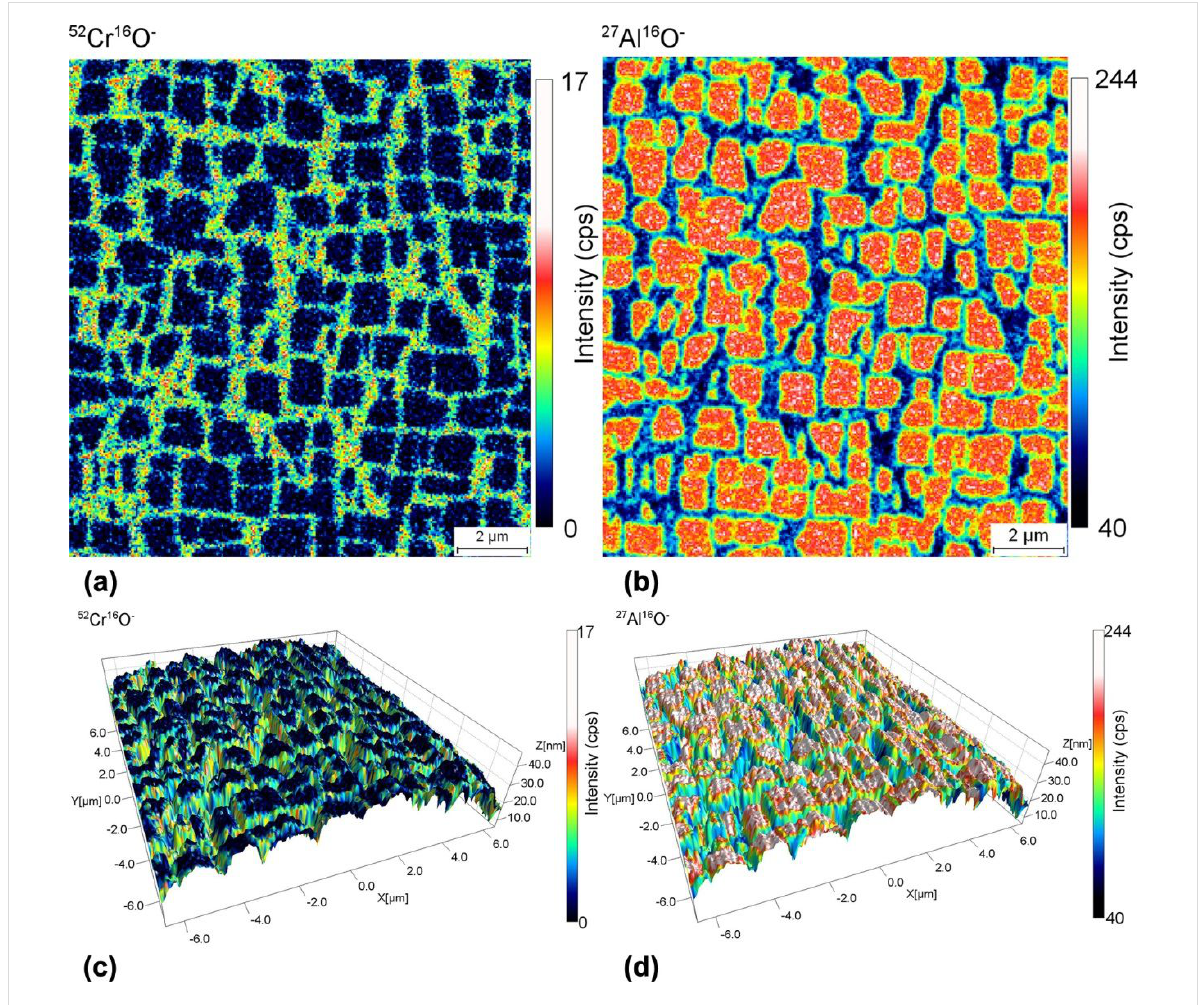
Figure 2: 52 Cr 16 O − (a) and 27 Al 16 O − (b) secondary ion intensity recorded by the NanoSIMS instrument during the analysis of nickel-based super- alloy. The corresponding 3D SIMS-SPM reconstructions nicely show the correlations between the chemical composition and the topography (c) and (d).